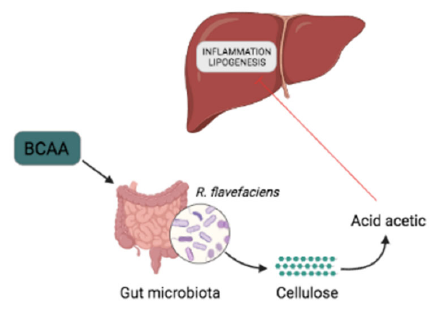
Figure 2. BCAAs alleviate NAFLD. BCAA supplementation favors the abundance of R. flavefaciens. and acetic acid synthesis, which reduces liver inflammation and the expression of lipogenesis genes ( FAB and ACC